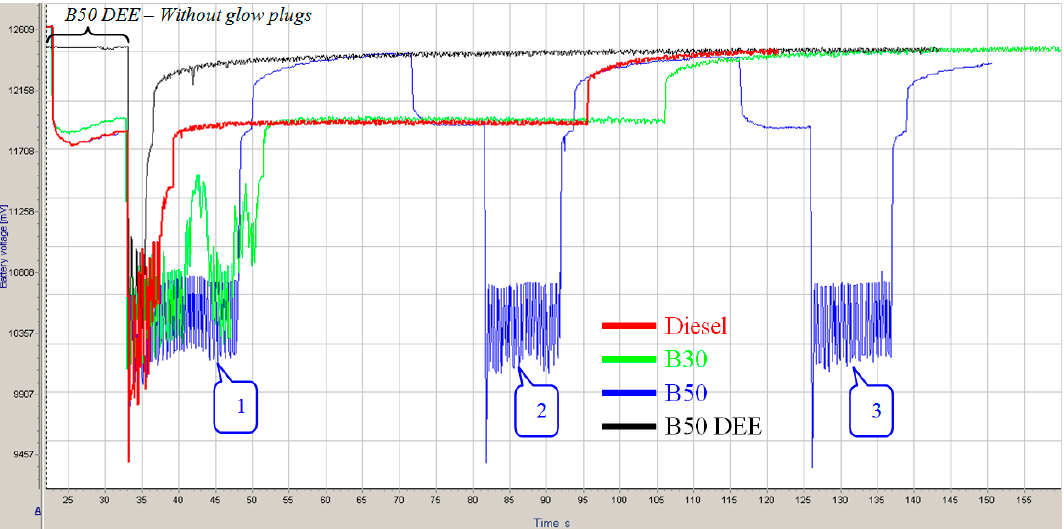
Figure 2. Battery voltage evolution.